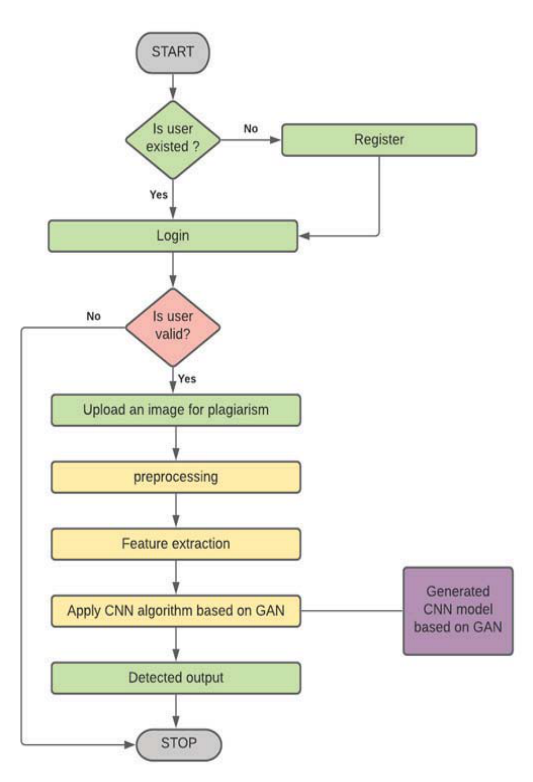
Fig. 2. Flow diagram of the